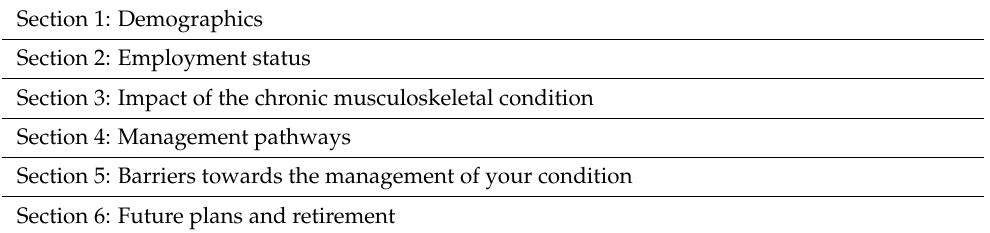
Table 2. Organisation of the online questionnaire into sections.